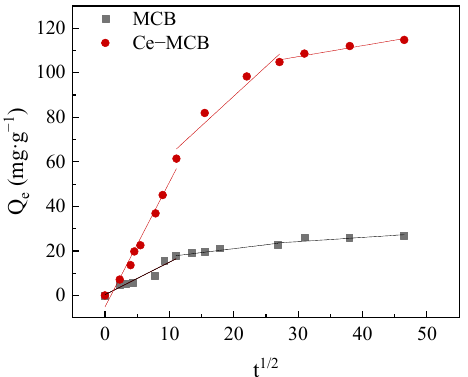
Figure 12. Intra-particle diffusion model of biochar to Pb 2+. Table 3. The fitting parameters of intra-particle diffusion.